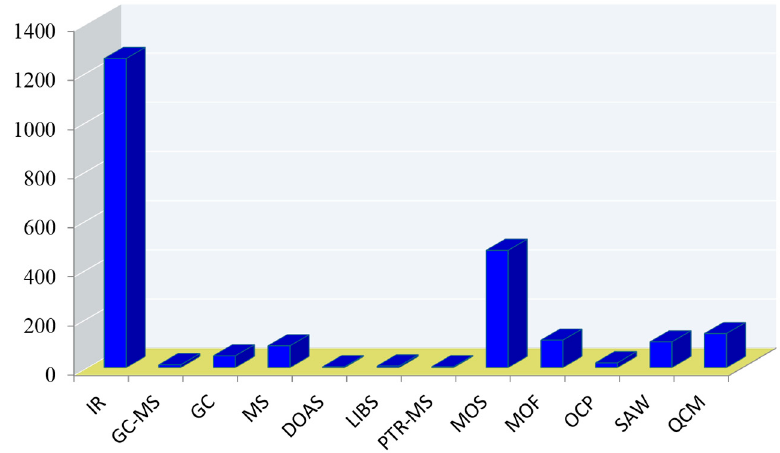
Figure 1. Number of articles published in English on the subject of analytical tools used for “gas sensing,” as determined by SciFinder on 18 August 2018. IR, infrared spectroscopy; GC-MS, gas chromatography-mass spectrometry; DOAS, differential optical absorption spectroscopy; LIBS, laser-induced breakdown spectroscopy; PTR-MS, proton-transfer reaction mass spectrometry; MOS, metal oxide semiconductor; MOF, metal organic framework; OCP, organic conducting polymer; SAW, surface acoustic wave; QCM, quartz crystal microbalance.